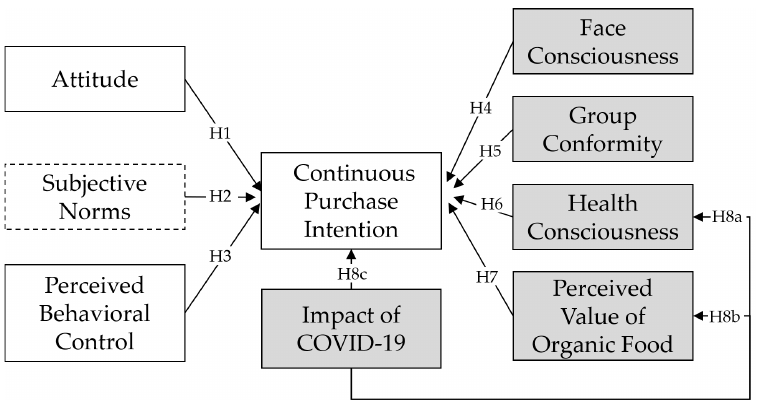
Figure 1. Conceptual Model. Note. Constructs derived from the original TPB model are demon- strated in white blocks; the white and grey solid blocks are the variables in the M-TPB model, and the grey blocks are the additional constructs based on the original TPB model; H1, Hypothesis 1; H2, Hypothesis 2; H3, Hypothesis 3; H4, Hypothesis 4; H5, Hypothesis 5; H6, Hypothesis 6; H7, Hypothesis 7; H8a, Hypothesis 8a; H8b, Hypothesis 8b; H8c, Hypothesis 8c.